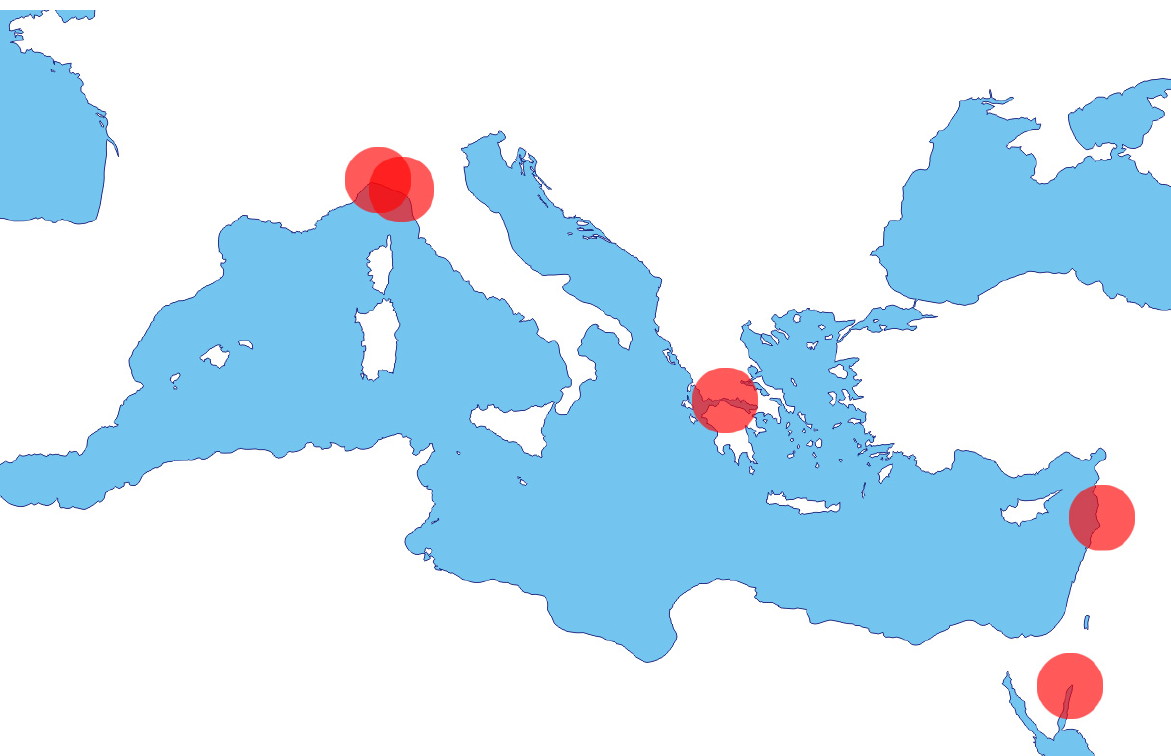
Figure 1: Distribution of MESP partners in the Mediterranean basin.